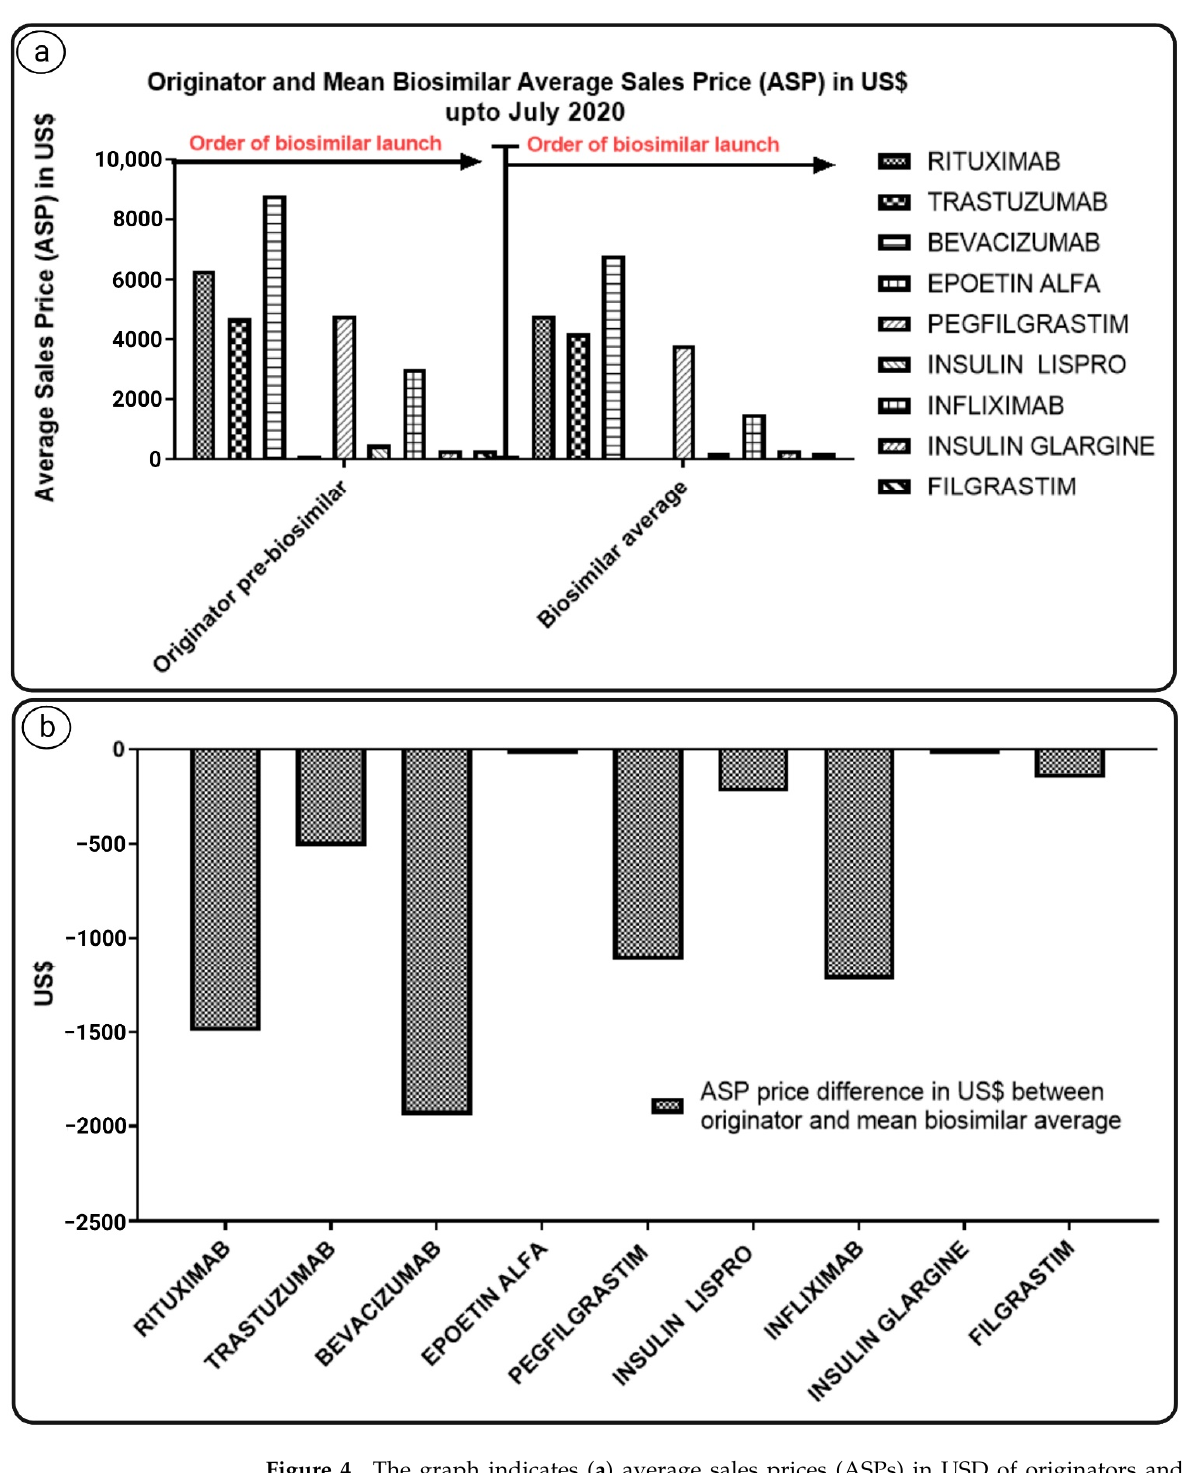
Figure 4. The graph indicates ( a ) average sales prices (ASPs) in USD of originators and mean biosimilar up to July 2020; ( b ) difference in ASP in USD of originators and mean biosimilar [22].